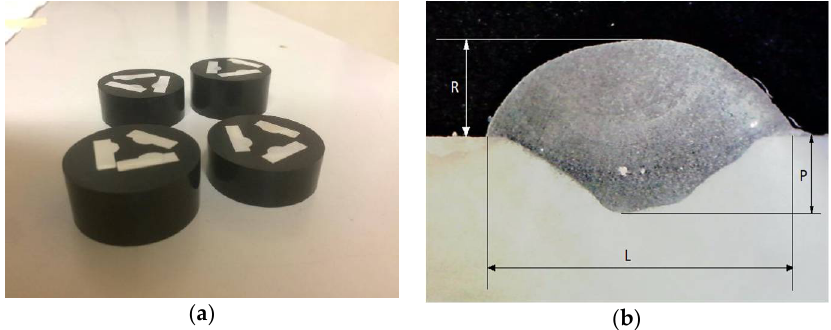
Figure 3. Experimental samples: ( a ) after built-in; ( b ) macroscopic view (amplification of